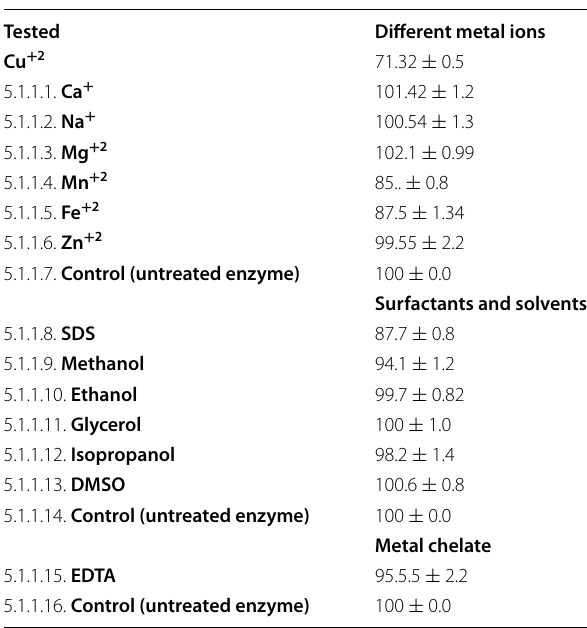
Table 1 Effect of some metal ions, SDS, solvents, and inhibitors on the activity of recombinant cellSNSY enzyme activity Residual activity of recombinant cellSNSY activity (%)Mean